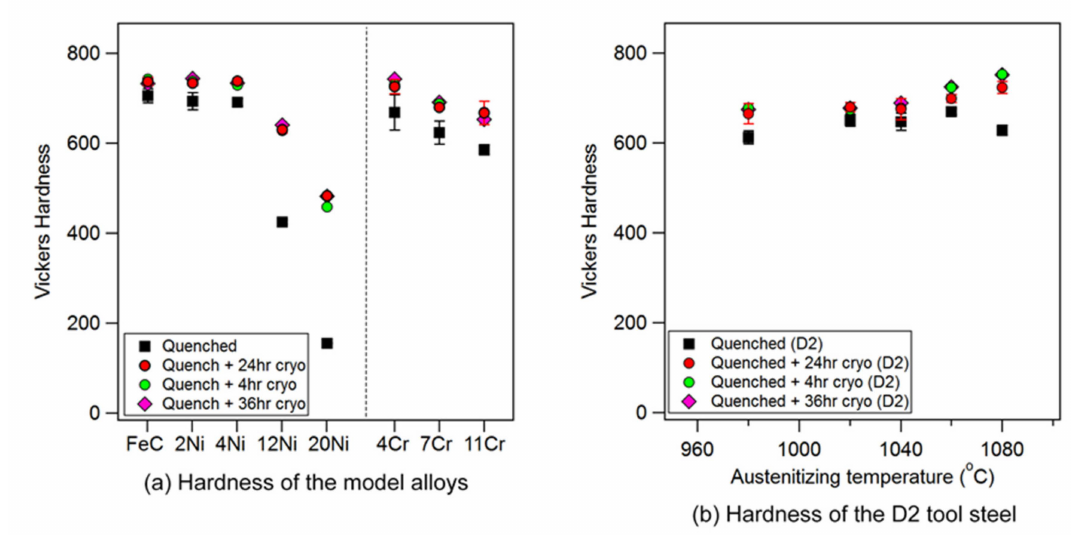
Figure 3. Vickers hardness of martensite for all alloys examined in this study. Data shown for cryogenic soaking times of 4, 24, and 36 h. Fitting error approximately the same size as data points.